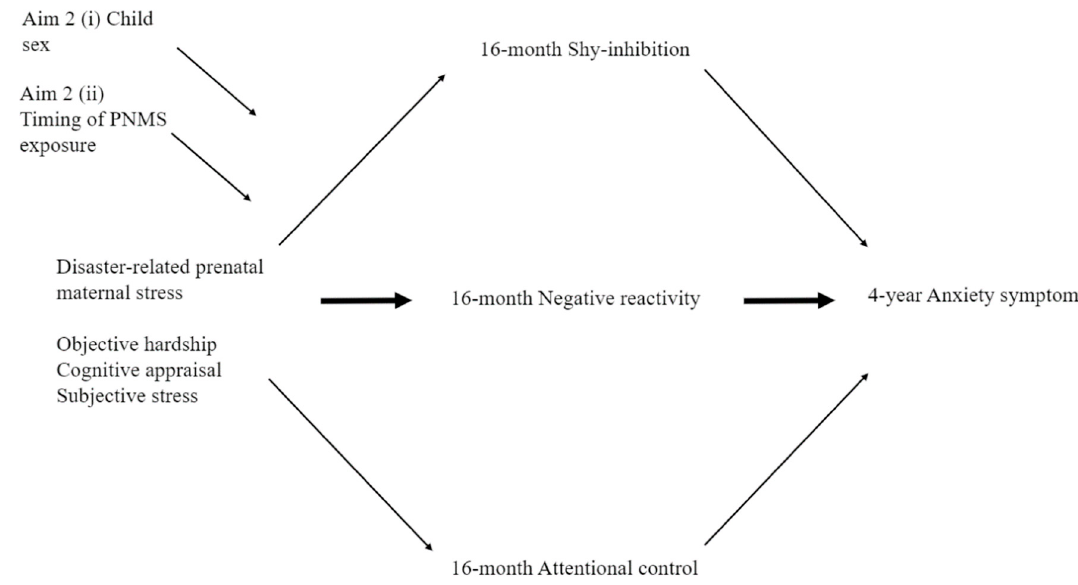
Figure 2. Conceptual diagram outlining the full moderated mediation model of the indirect effects of disaster-related prenatal maternal stress (PNMS) on child internalizing behaviors as moderated by (a) child sex or (b) timing of exposure.